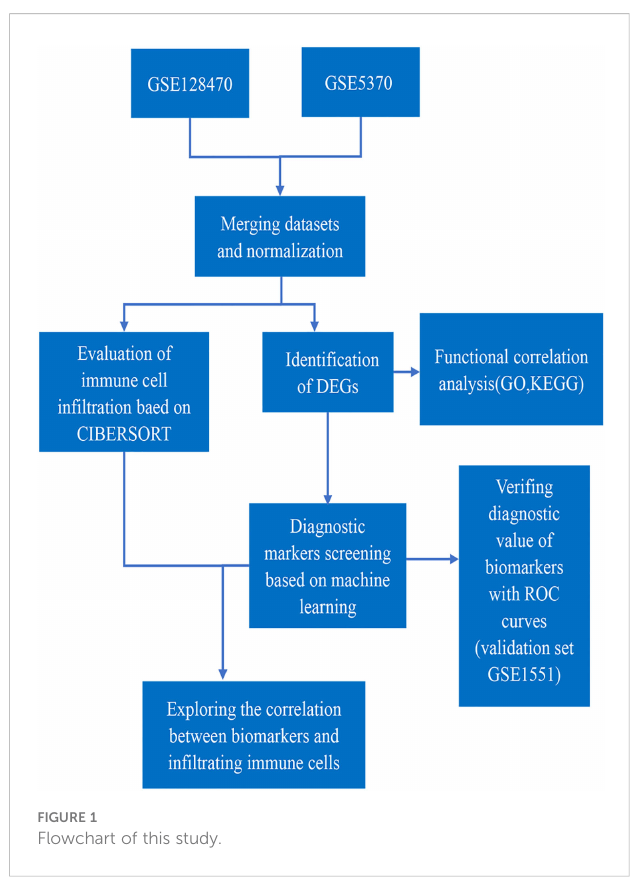
FIGURE 1 Flowchart of this